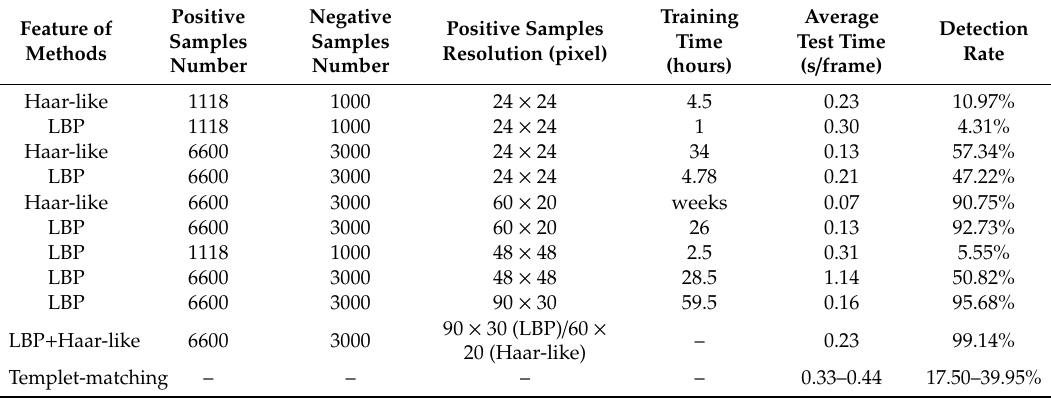
Figure 13. ROC curve for ISME detectors with stepsize = 1.0. Table 3. Comparison of different ISME detectors.